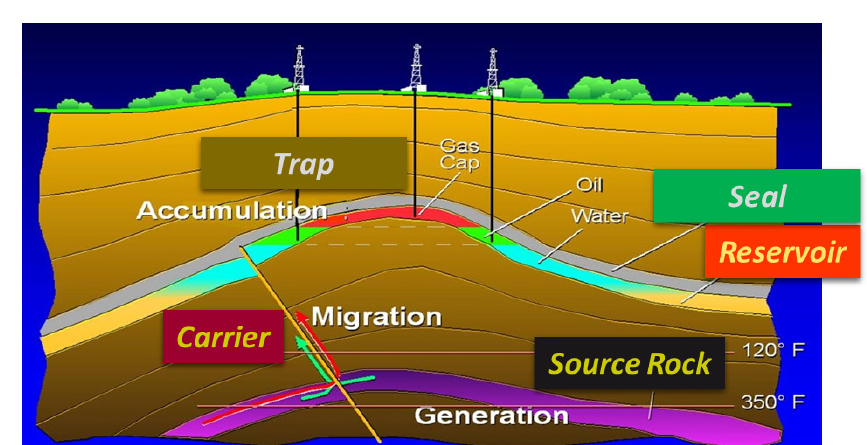
Fig. 2. – Within a sedimentary basin: the 5 elements of the petroleum system.